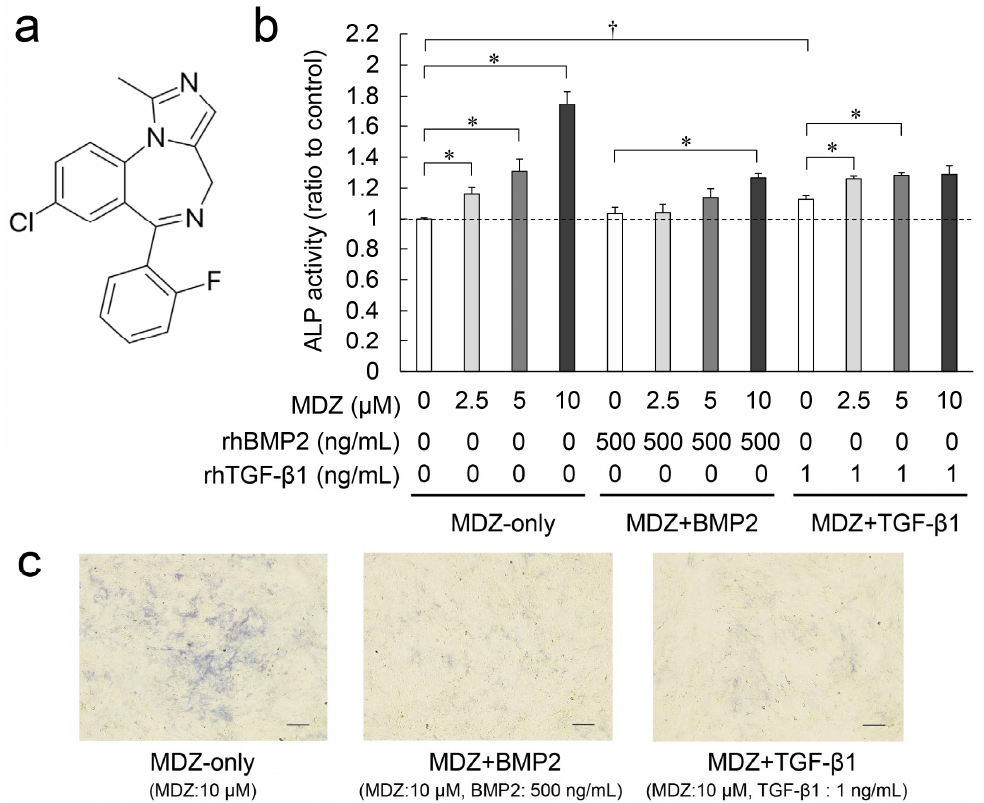
Figure 1. Combined effect of midazolam ( MDZ) with bone morphogenetic protein 2 (BMP2) or transforming growth factor beta 1 (TGF-β1) on alkaline phosphatase ( ALP) activity in the porcine dental pulp-derived ( PPU-7) cell line. ( a ) Structure of MDZ. ( b ) ALP-inducing activity of midazolam without BMP2 or TGF-β1 (MDZ-only), midazolam with BMP2 (MDZ and BMP2) and midazolam with TGF-β1 (MDZ and TGF-β1) in PPU-7 cells. ALP activities are indicated as increasing or decreasing ratios relative to the level of the control (i.e., 0 µM MDZ, 0 ng/mL BMP2, 0 ng/mL TGF-β1), which was set at 1 (dotted line). Values are the means ± standard error of six culture wells. Significant differences are indicated by an asterisk (* p < 0.05, Steel’s test) or a dagger ( † p < 0.05, Mann–Whitney U-test). ( c ) ALP staining for PPU-7 cells cultured with MDZ-only, MDZ and BMP2, MDZ and TGF-β1 (Scale bar: 200 µm).